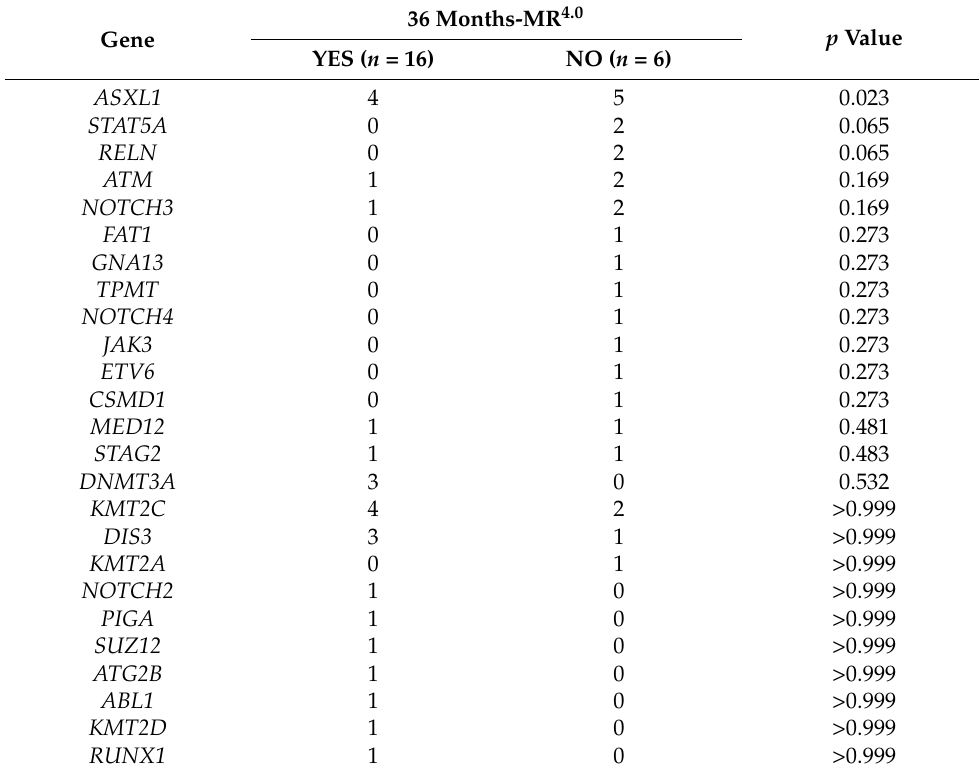
Table 3. Mutation analysis in the 36M-MR 4.0 group and non 36M-MR 4.0 group.